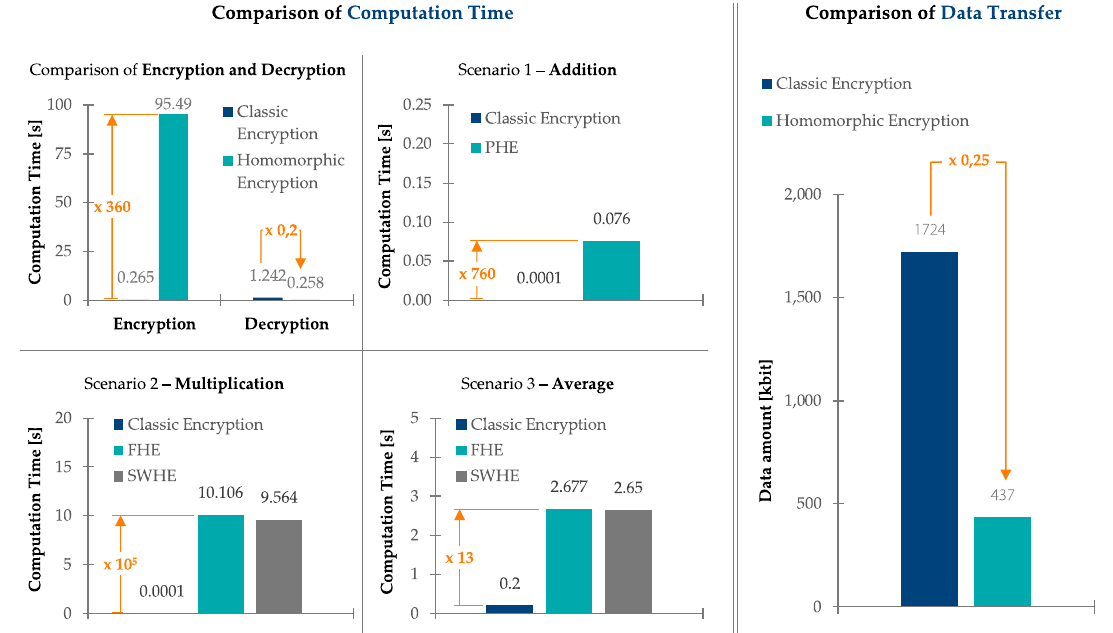
Figure 5. Results of experimental comparison.